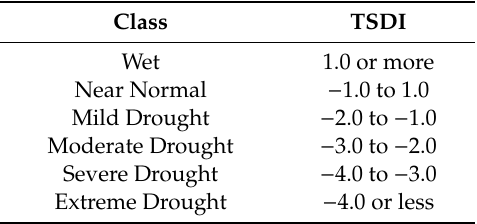
Table 4. The classification of the area condition by using TSDI.